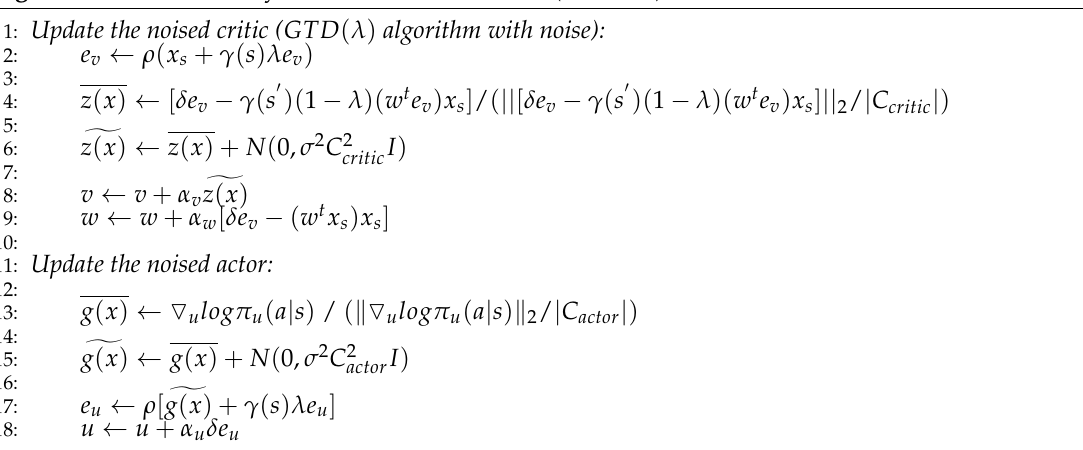
Algorithm 4 Differentially Private Actor and Critic (DP-Both)